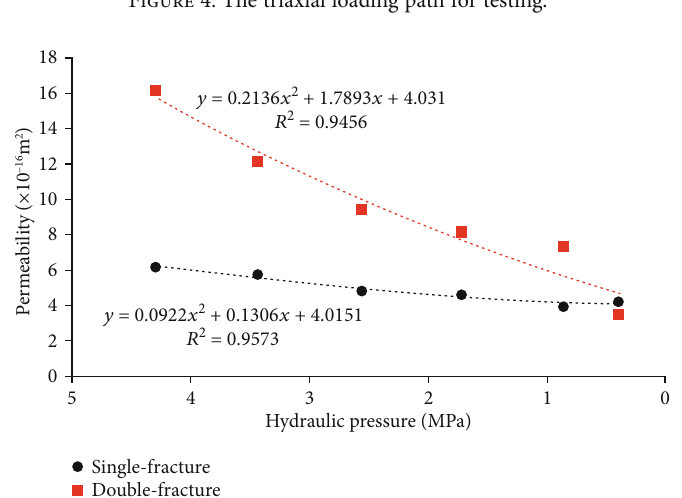
Figure 4: The triaxial loading path for testing.